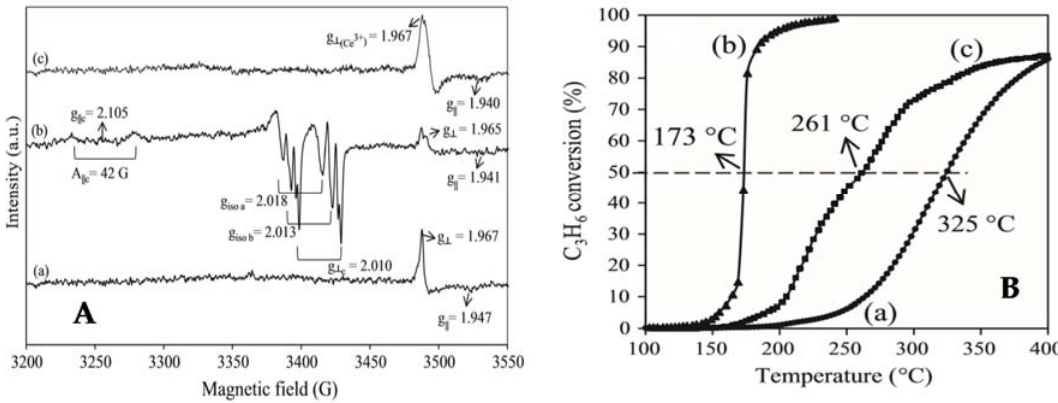
Figure 14. ( A ) EPR spectra for (a) CeO 2 , (b) 10% Ag/CeO 2 (Imp), and (c) 10% Ag/CeO 2 (DP) recorded at -196 °C after treatment under vacuum for 30 min. ( B ) Propylene conversion over (a) CeO 2 , (b) 10% Ag/CeO 2 (Imp), and (c) 10% Ag/CeO 2 (DP). Reprinted from [41] with the permission of the Elsevier.